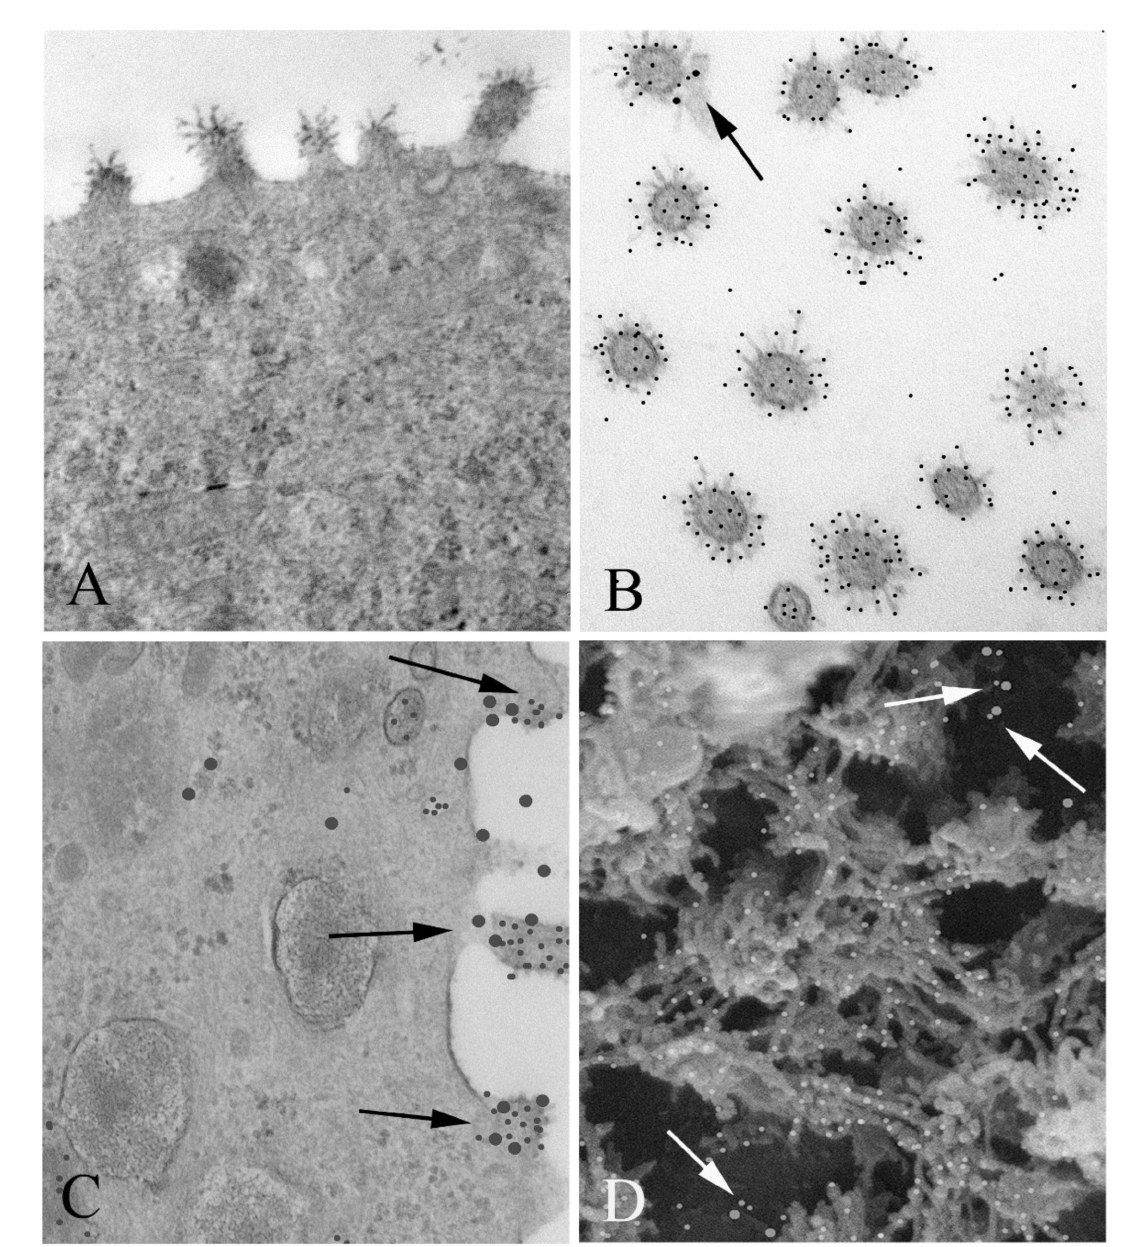
Figure 1. Co-localization of respiratory syncytial virus (RSV) and nucleolin in infected MDCK cells: ( A ) TEM of an RSV infected MDCK cell. Note the virus particles associated with the apical surface. Magnification 60,000 × . ( B ) Cross sections of virus particles near the apical surface which have been double immunogold labeled for RSV (small particles) and nucleolin (large particles). A small portion of the apical membrane is seen with the virus, which is labeled with large particles (arrow). Magnification 60,000 × . ( C ) TEM of a RSV infected MDCK cell, immunogold labeled for nucleolin and RSV. Nucleolin is seen at the periphery of the viral particles associated with the apical membrane (arrows) (large particles), while RSV antibody label (small particles) was confined to the interior of the virus. ( D ) SEM of the surface of an infected cell was imaged using a Wein filter. Numerous co-localizations are seen (arrows). Magnification 70,000 ×